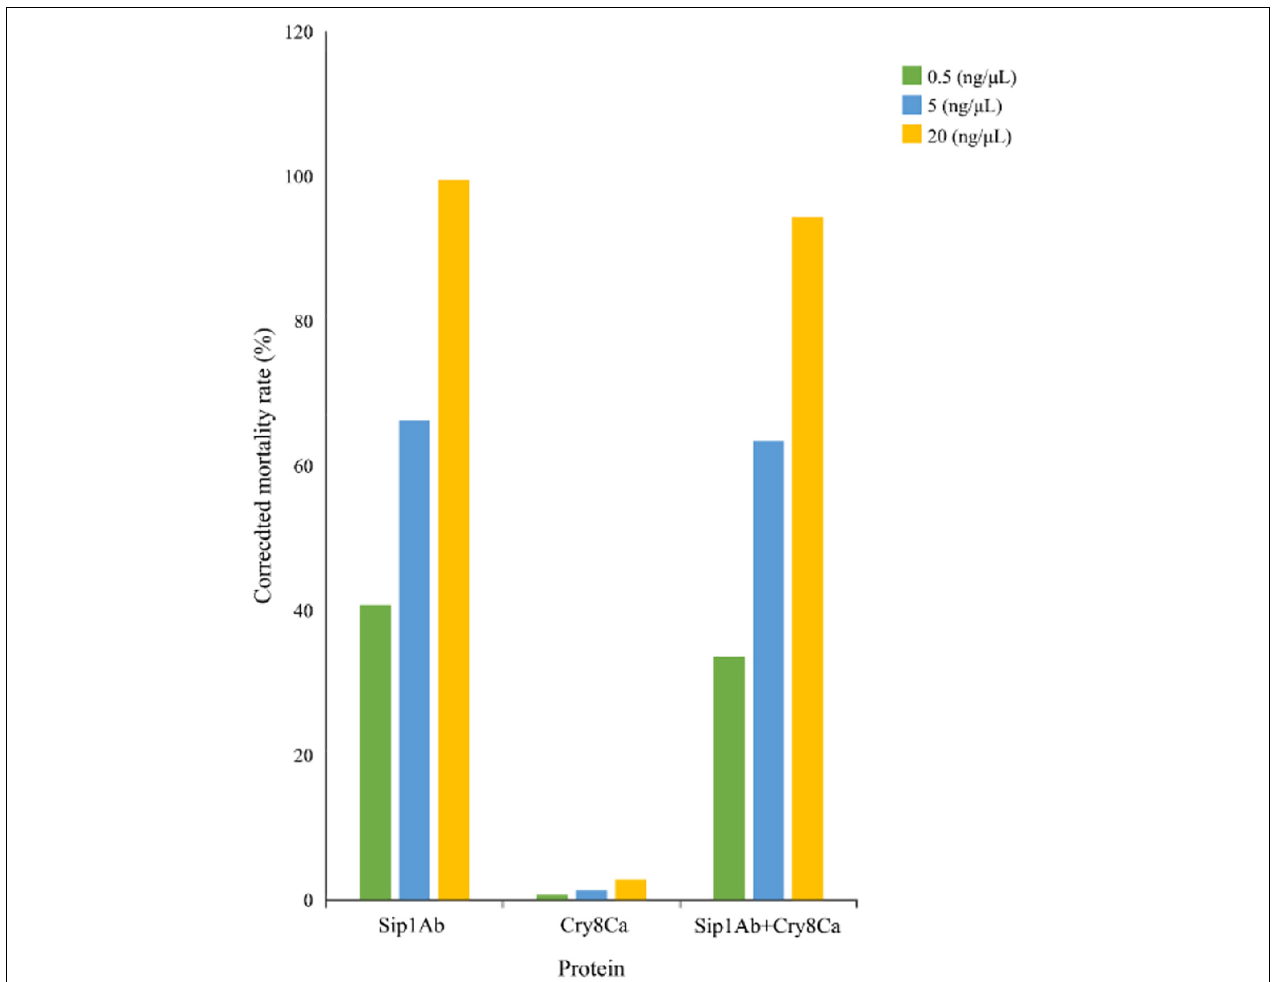
FIGURE 3 | Qualitative bioassay results of Sip1Ab and Cry8Ca against Colaphellus bowringi .